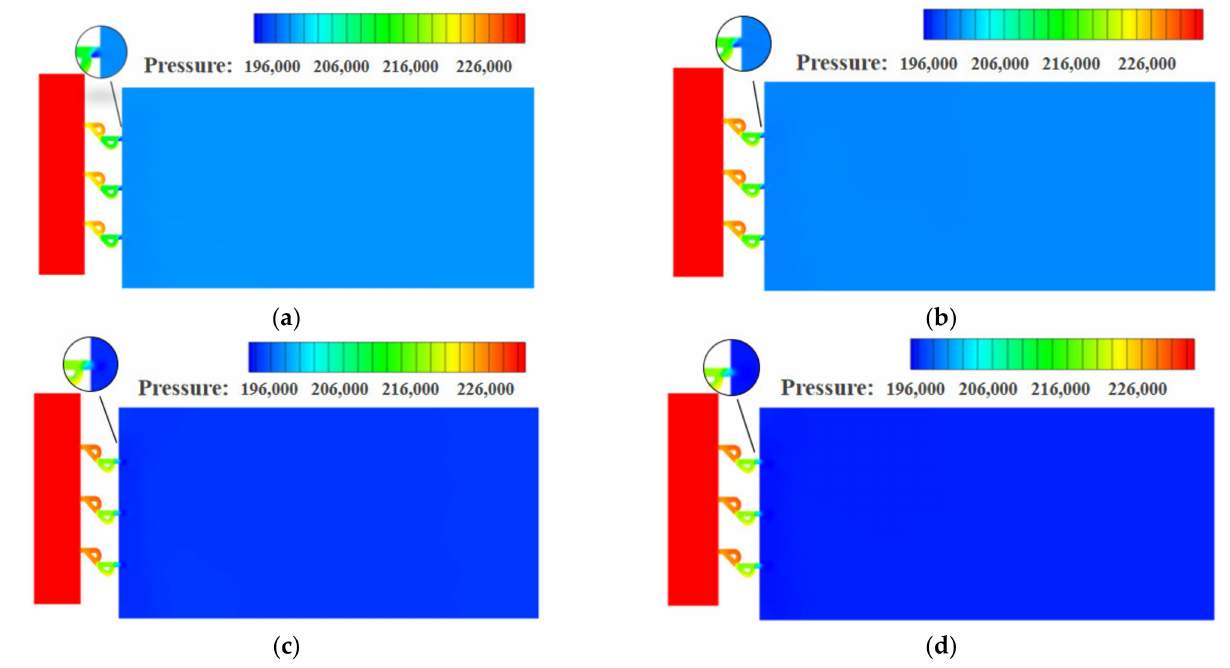
Figure 6. Pressure distribution on the symmetry plane for the Tesla-type orifice structure under differ- ent mass flow rates (pressure in Pascal). ( a ) Q m = 0.02 kg s − 1 . ( b ) Q m = 0.1 kg s − 1 . ( c ) Q m = 0.5 kg s − 1 . ( d ) Q m = 1 kg s − 1